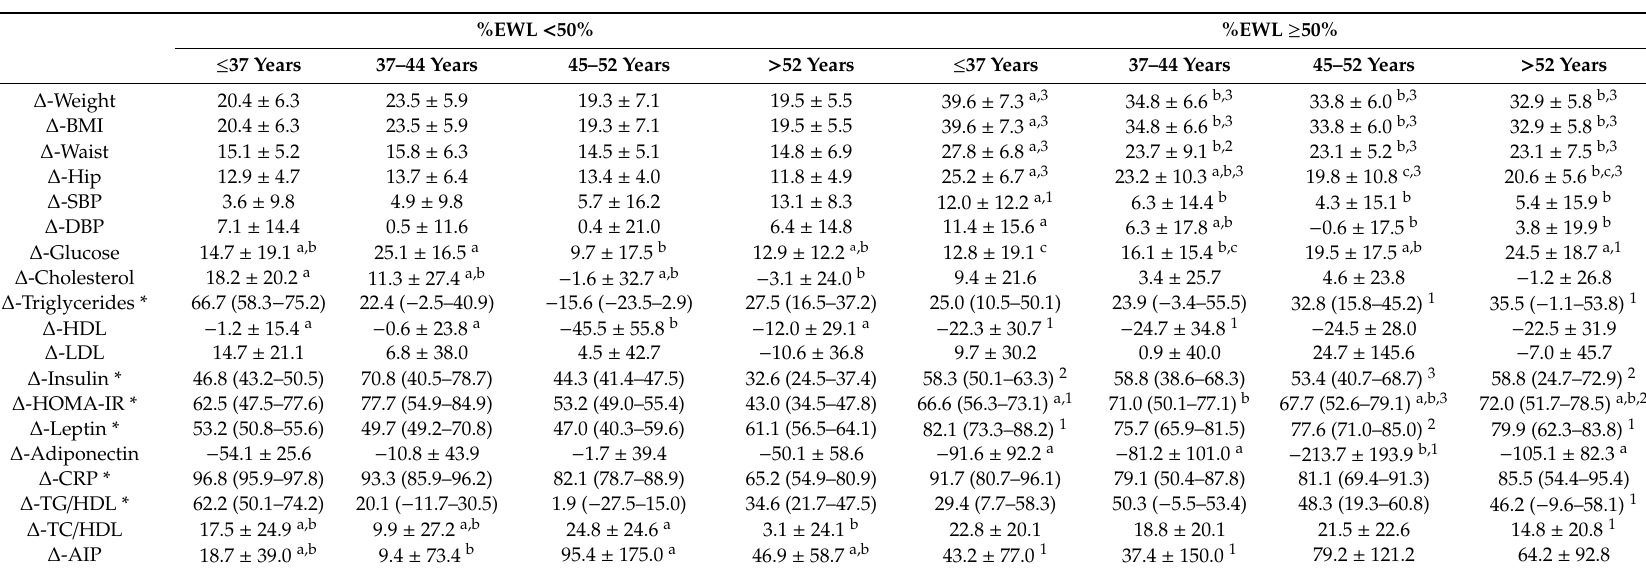
Table 7. Percentage change ( ∆ ) of anthropometric and biochemical variables of patients with morbid obesity classified according to the percentage of excess weight loss (%EWL) and